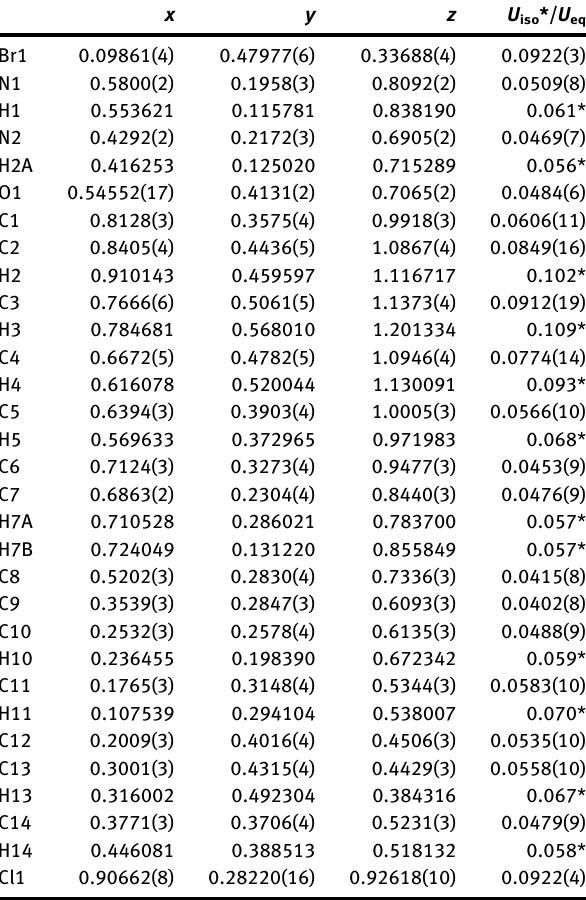
Table  : Fractional atomic coordinates and isotropic or equivalent isotropic displacement parameters (Å 